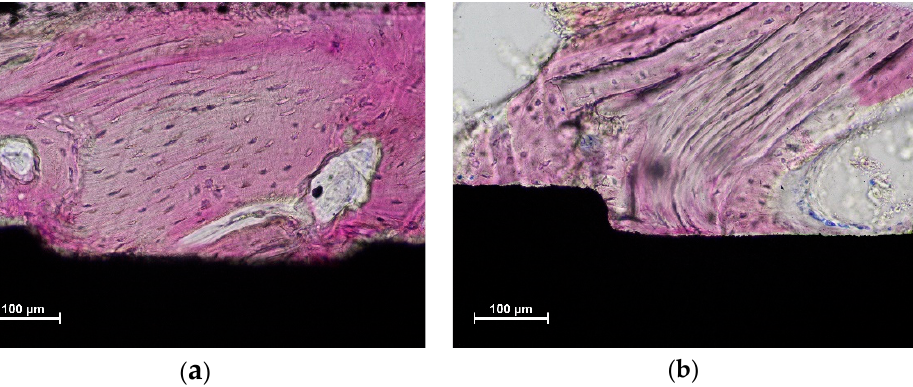
Figure 4. Old parent bone of the sinus floor still in contact with the implant surface in both figures ( a , b ). Acid fuchsine and toluidine blue stain. Xenograft particles were included into the newly-formed bone (Figure 5a), and, in several instances, the graft was in contact with the implant surface (Figure 5a,b).